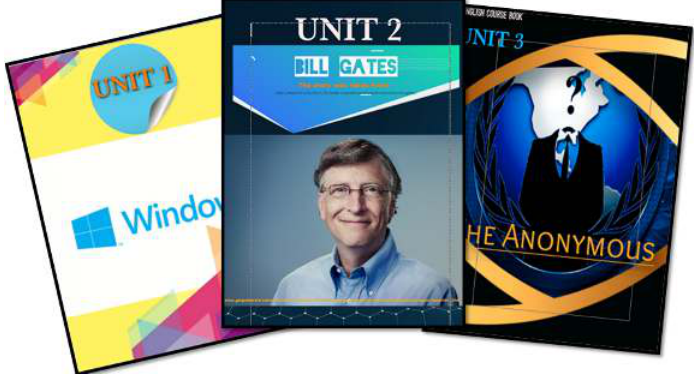
Figure 1. First pages of the developed